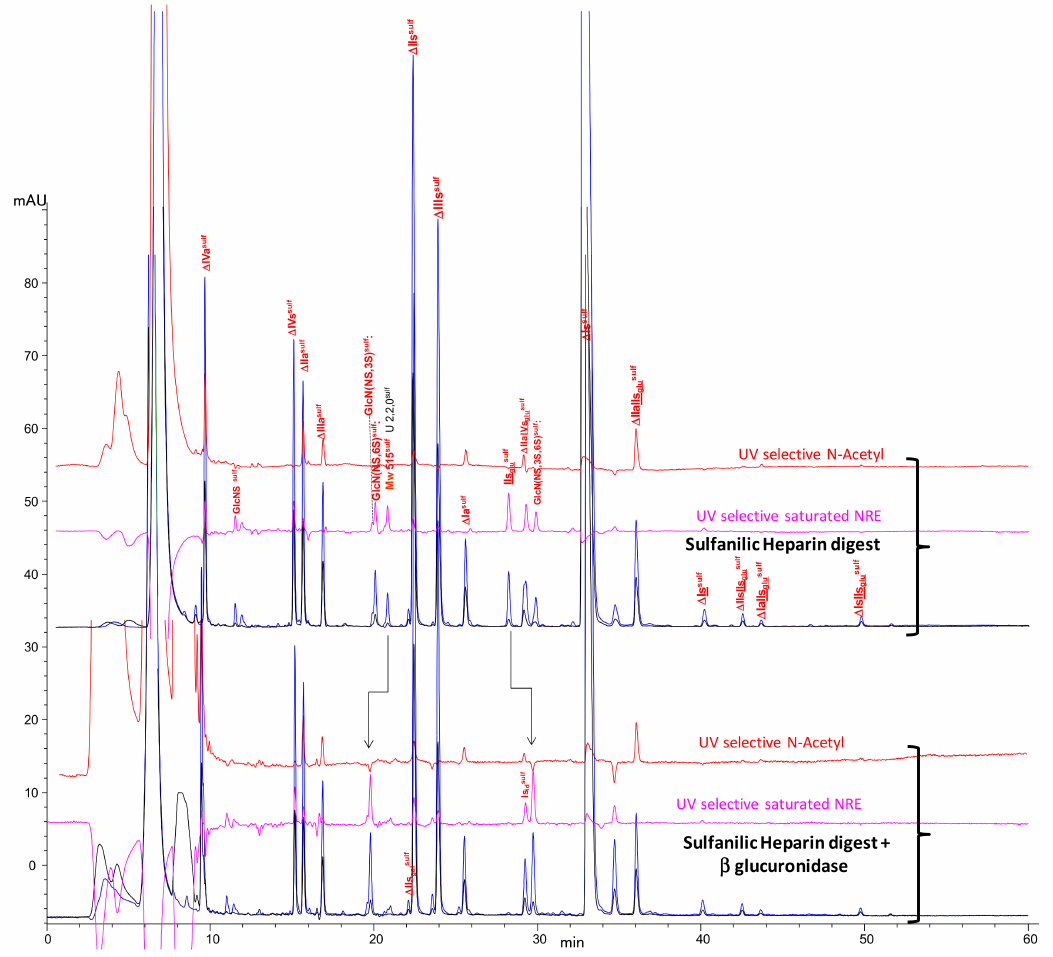
Figure 7. Influence on the AS11 chromatogram of β - d -glucuronidase addition to the heparinase digest of PMH with sulfanilic